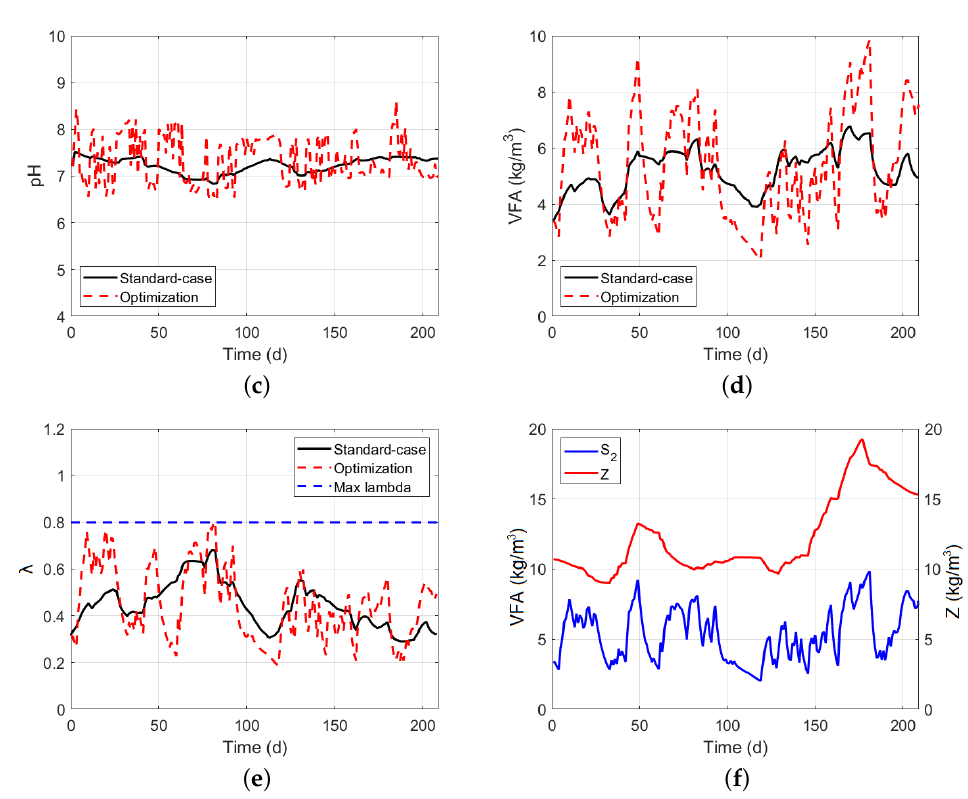
Figure 9. MPC controller with restrictions, maximizing the volume of CH 4 . ( a ) Volume of CH 4 ;